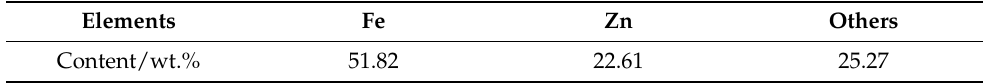
Table 7. The element content in magnetic